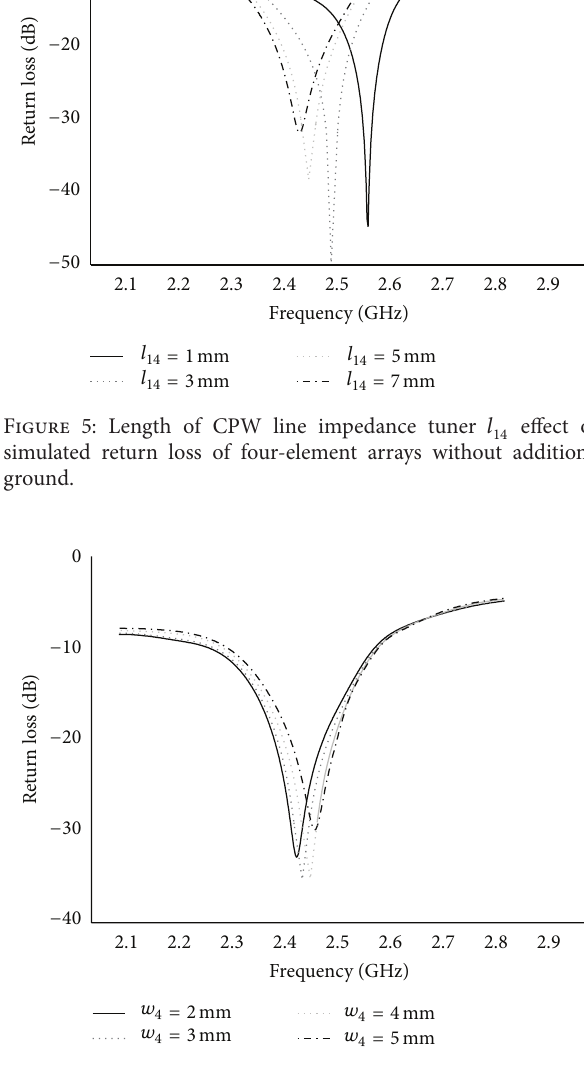
Figure 6: Width of dipole impedance tuner 𝑤 4 effect on simulated return loss of four-element arrays without additional ground.